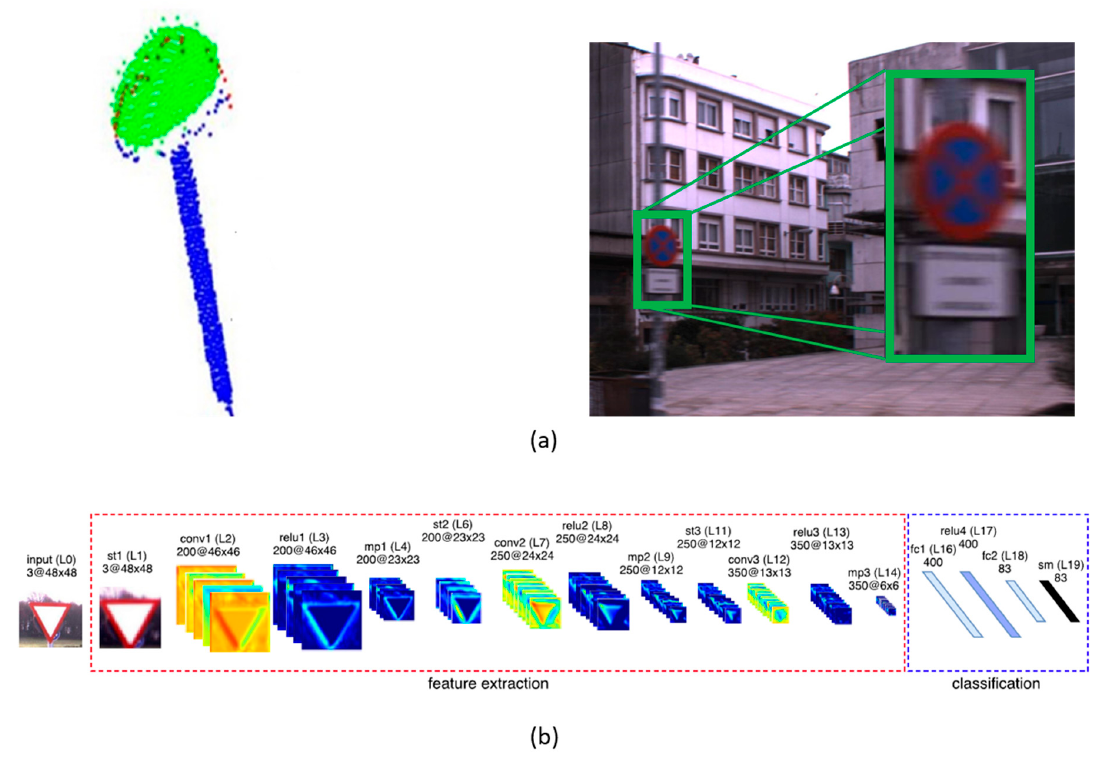
Figure 5. Traffic signs. ( a ) Soilán et al. [100] detect traffic sign panels applying intensity filters on a previously segmented point cloud (left), define geometric parameters for each traffic sign and project the panel on georeferenced RGB images (right). ( b ) Arcos et al. [107] classify those RGB images applying a Deep Neural Network that comprises convolutional and spatial transformer layers.